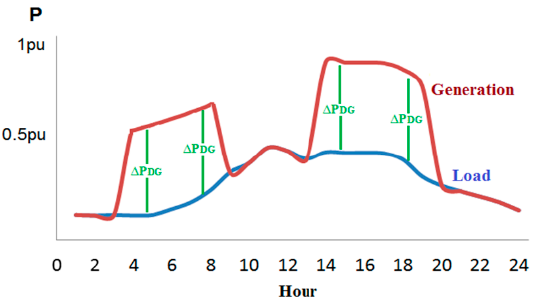
Figure 6. MOR model 2 with two operating intervals available to distributor.